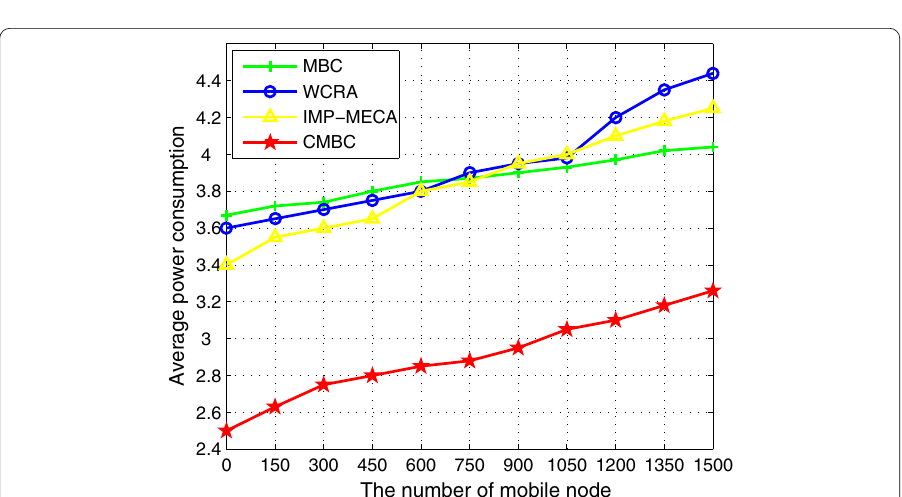
Fig. 6 Results comparison between the number of mobile node and the average power